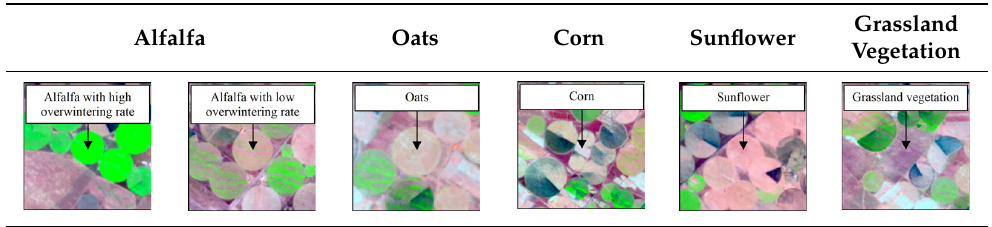
Table 7. Image features of different vegetation types at the spring regreening stage (false color synthesis).